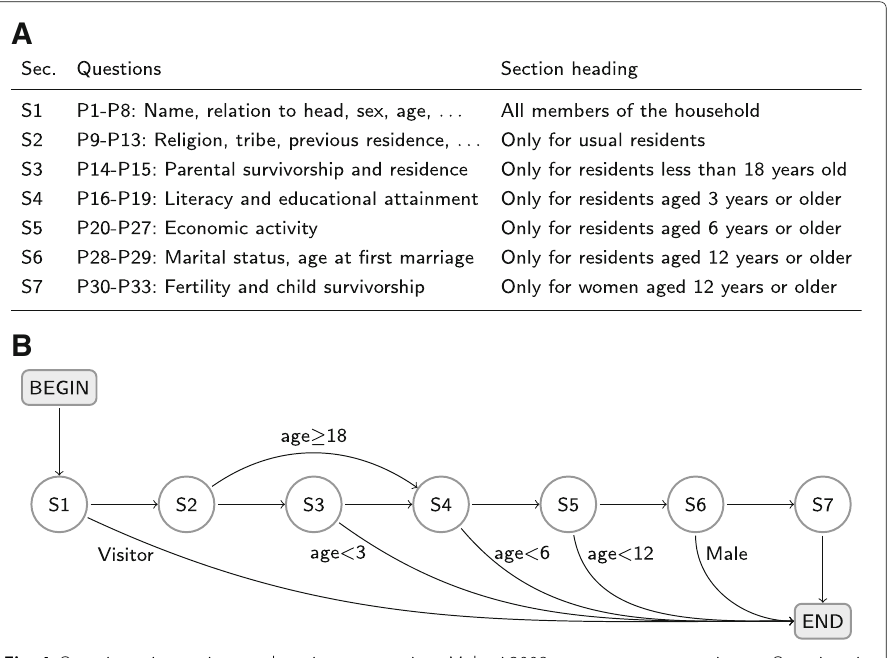
Fig. 4 Questionnaire sections and section progressions Malawi 2008 census person questions. a Questions in each section (left) and section headings (right). See questionnaire (Minnesota Population Center 2018b) for full detail. b Flow diagram of sections and section progressions. All sections except S7 are branching sections. All sections except S2 are end sections. S4 is the only merge